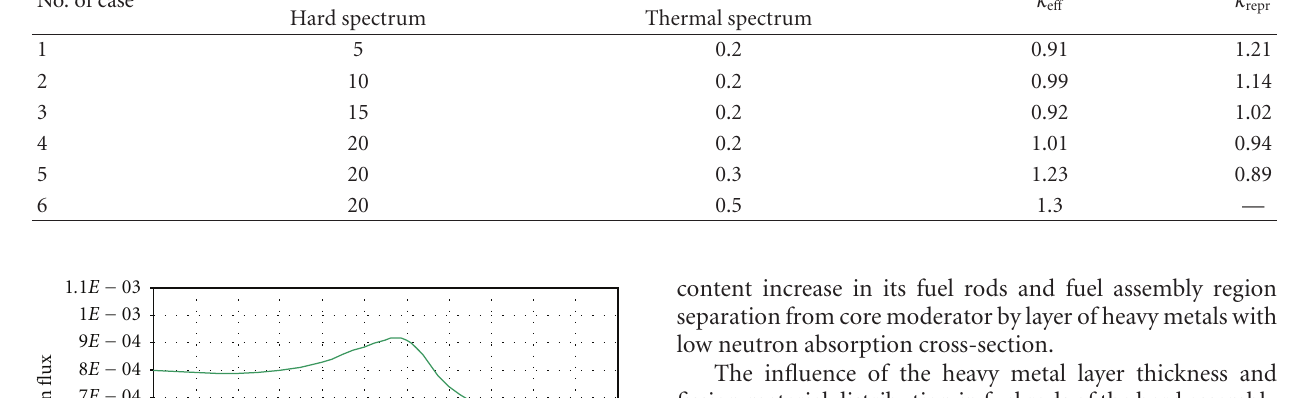
Table 4: Dependence of the multiplication constant and the reproduction coe ffi cient from fission material contents in fuel assemblies. No. of case